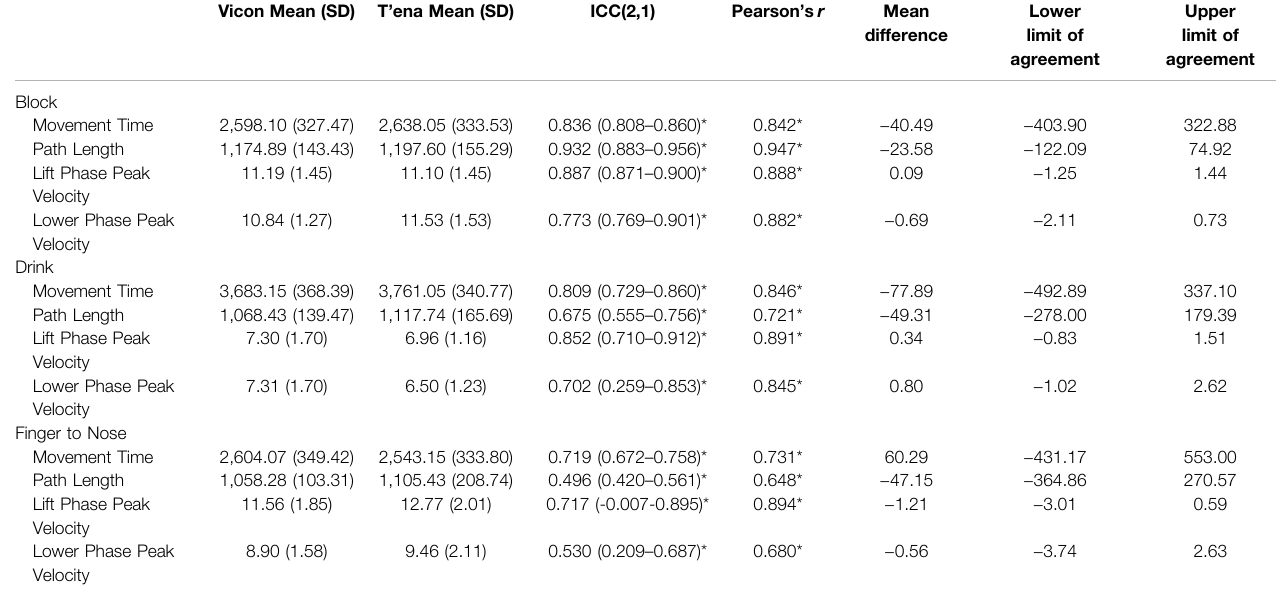
TABLE 2 | Kinematic metrics, correlations, intraclass correlations, and Bland-Altman analysis indicating bias and limits of agreement between the T ’ ena sensor and Vicon motion capture system. Vicon Mean (SD) T ’ ena Mean